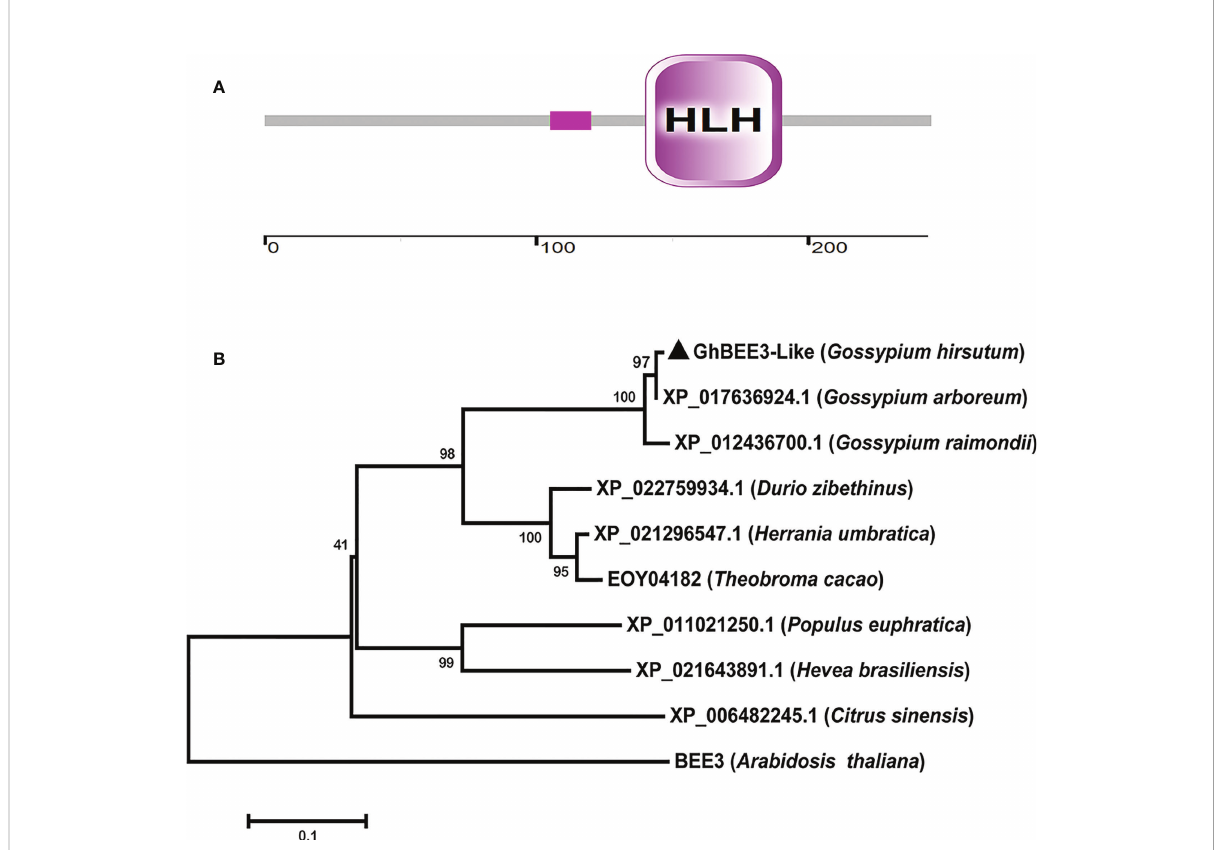
FIGURE 1 GhBEE3-Like protein domain analysis and the phylogenetic relationship between GhBEE3-Like and its homologs in other species. (A) Domain analysis of GhBEE3-Like protein. The low compositional complexity is indicated by pink solid rectangle. The ruler is used to measure the number of amino acids. (B) The MEGA 7 program was used to generate a phylogenetic tree between GhBEE3-Like and its homologs in other plant species, including Gossypium arboreum , Gossypium raimondii , Durio zibethinus , Herrania umbratica , Theobroma cacao , Populus euphratica , Hevea brasiliensis , Citrus sinensis , and Arabidopsis thaliana . 1,000 replications were used for bootstrap